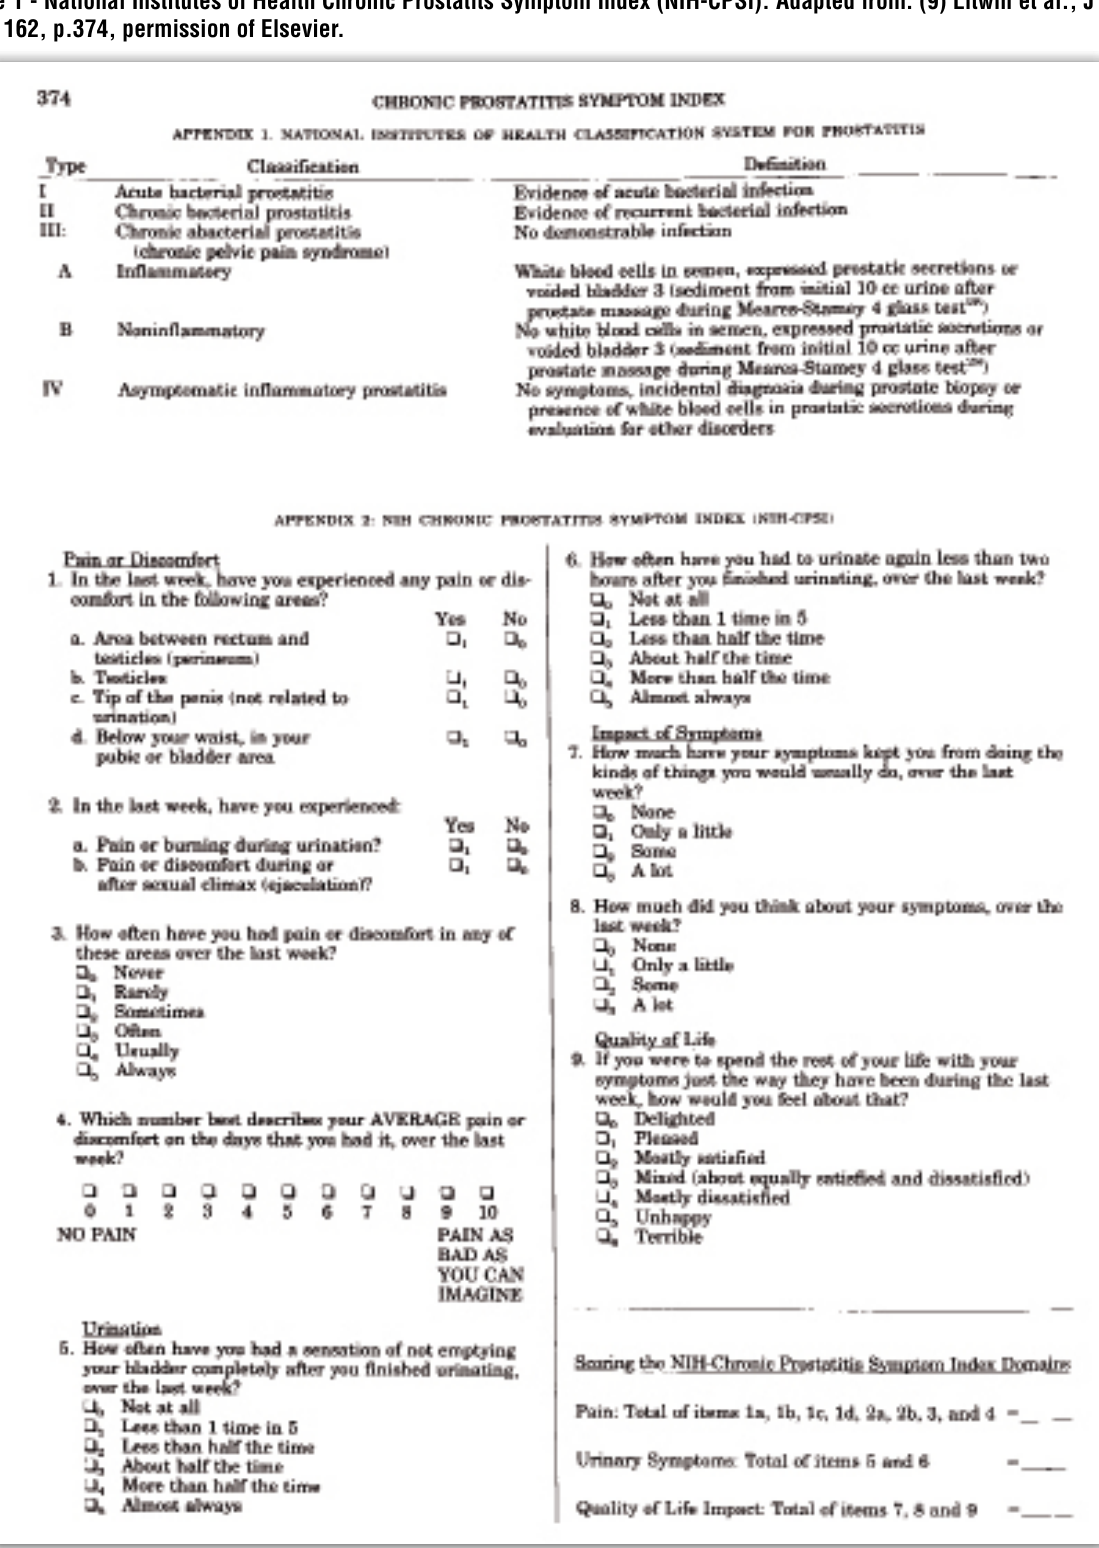
Figure 1 - National Institutes of Health Chronic Prostatits symptom Index (NIH-CPsI). Adapted from: (9) Litwin et al., J urol 1999; 162, p.374, permission of